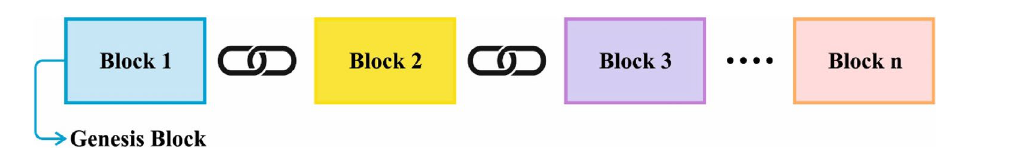
Figure 3. Blockchain